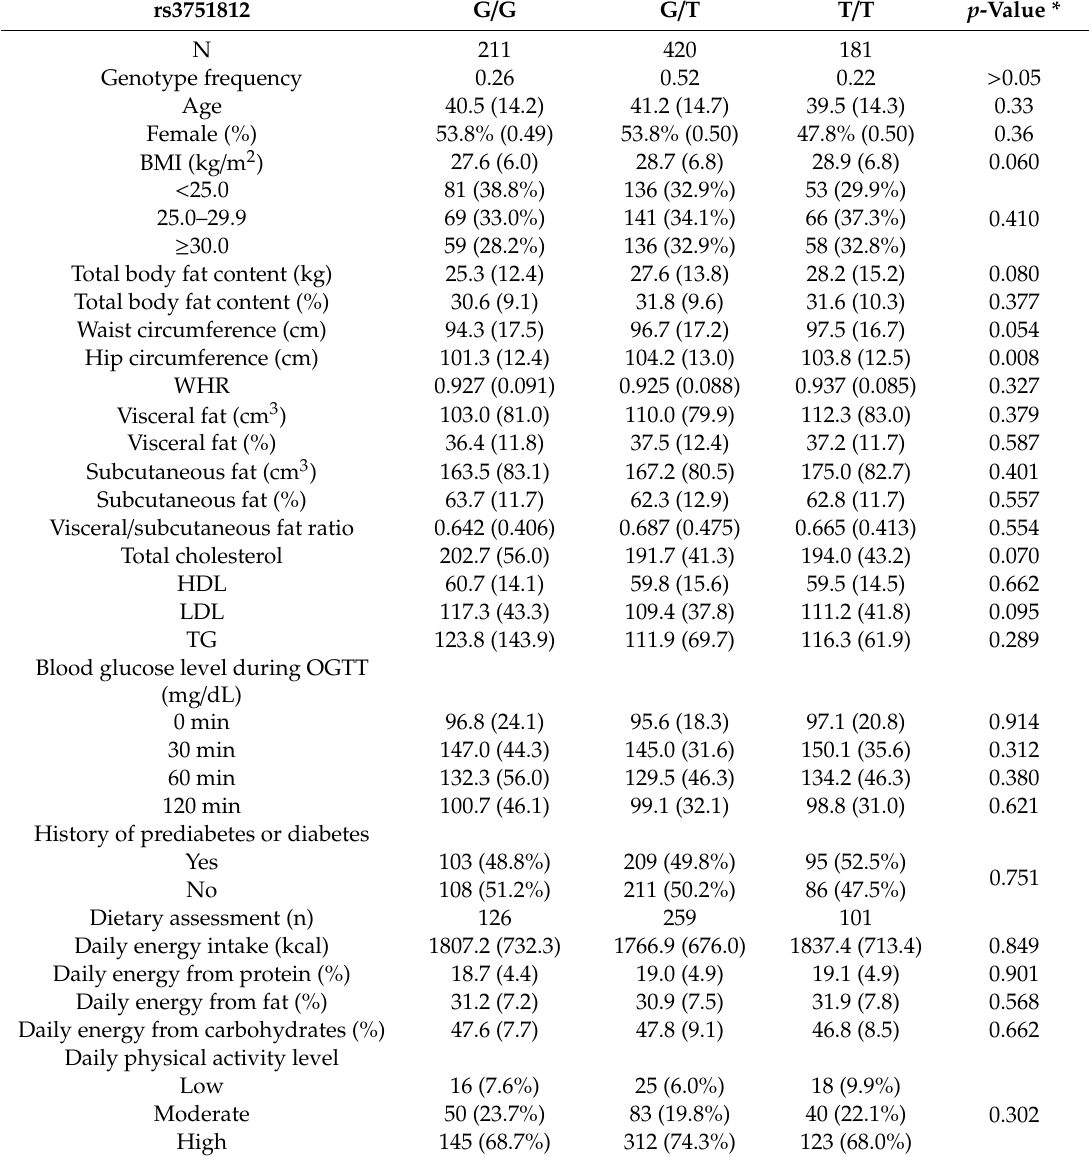
Table 2. Characteristics of participants stratified by rs3751812